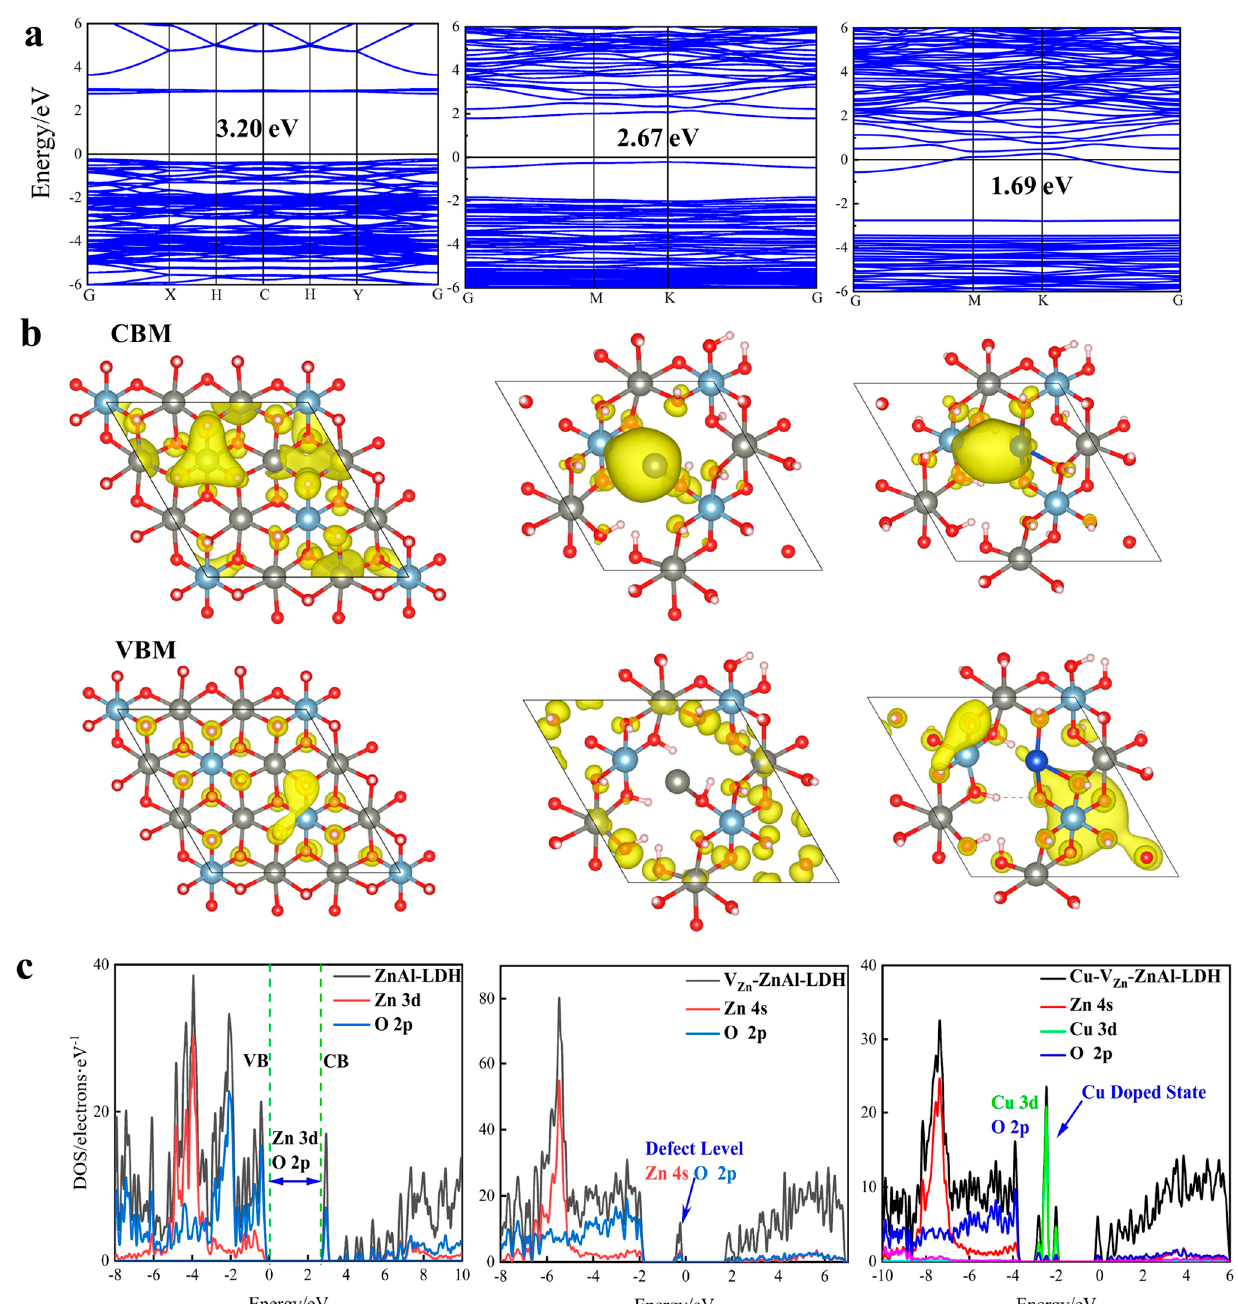
Figure 5. ( a ) Band structure, ( b ) charge density of VBM and CBM, and ( c ) related DOS of ZnAl-LDH (left), V Zn -ZnAl-LDH (middle), and Cu-V Zn -ZnAl-LDH (right).